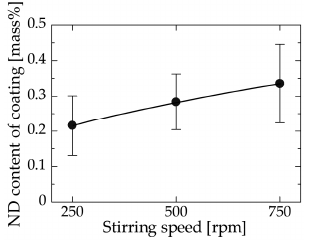
Figure 4. Relation between the stirring speed and the ND content of the coating.